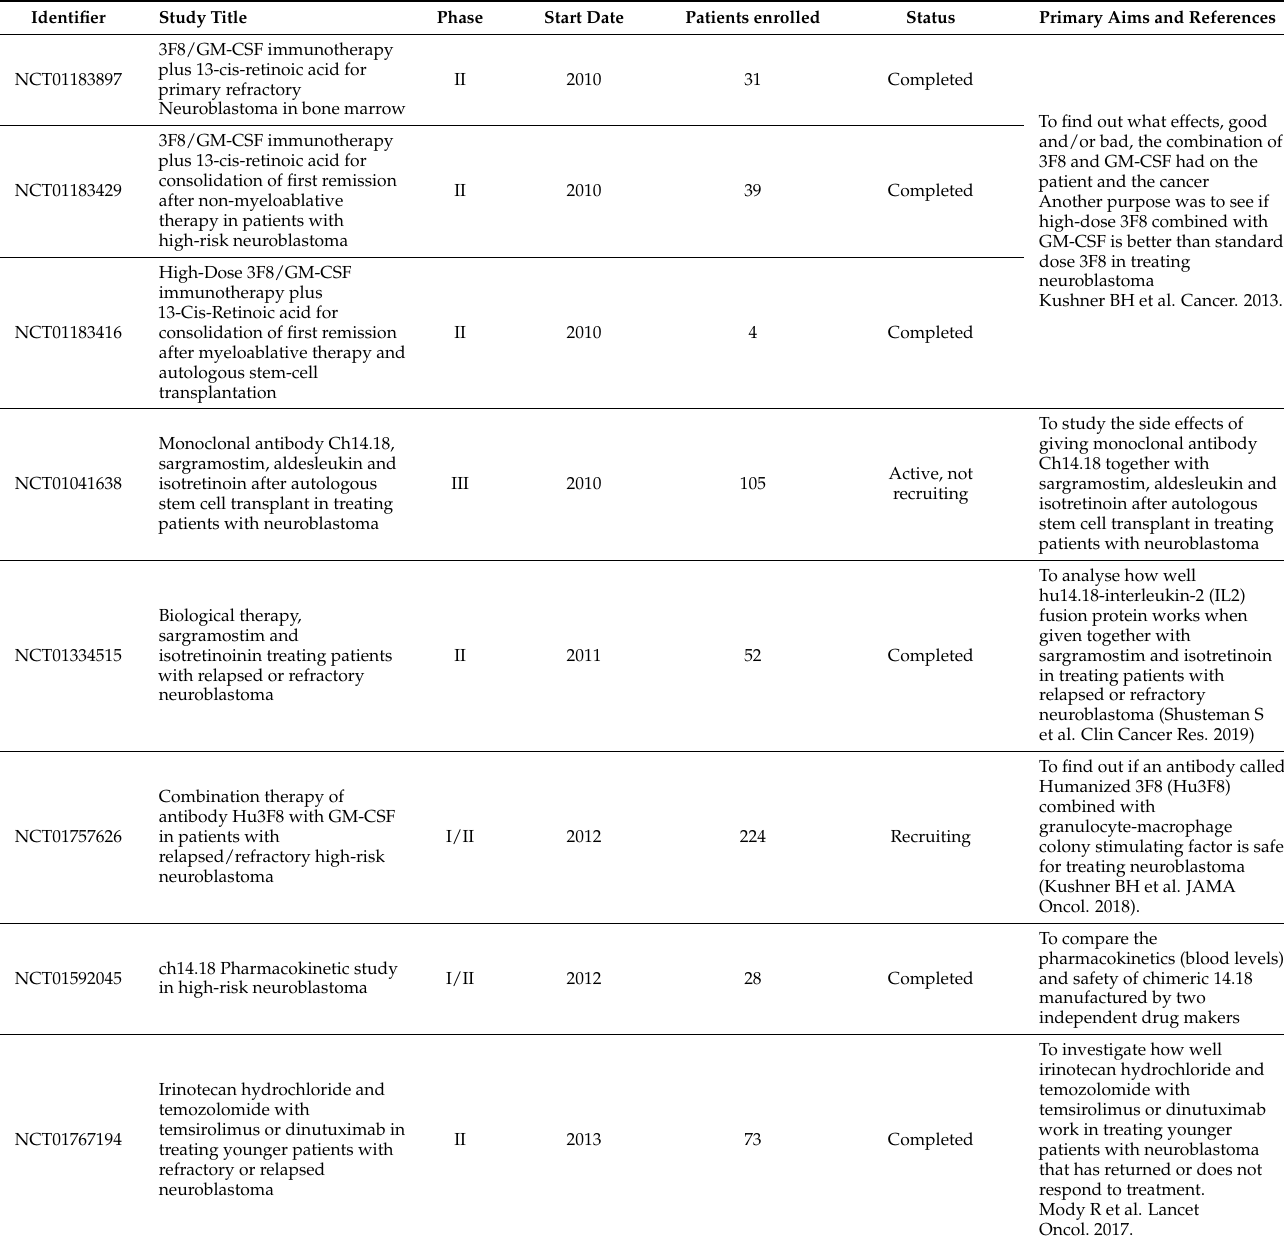
Table 2. Clinical trials using granulocyte-macrophage colony stimulating factor (GM-CSF) and anti-GD2 in the last ten